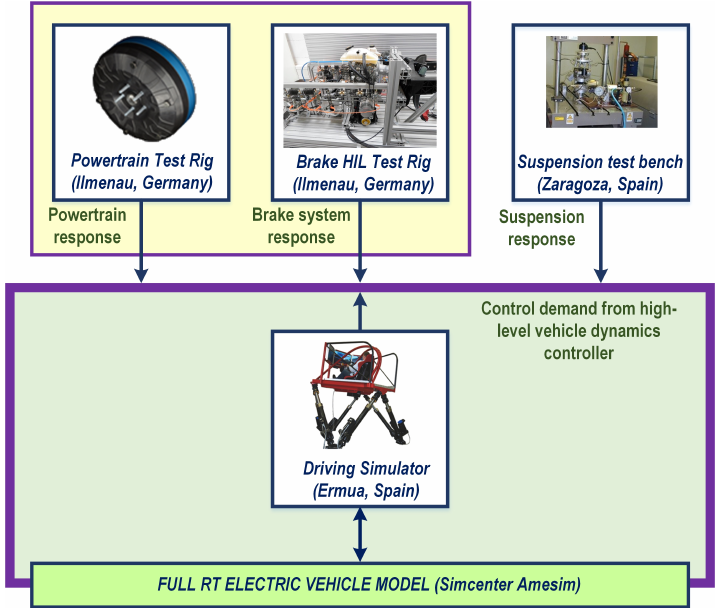
Figure 11. XILforEV configuration for integrated chassis control